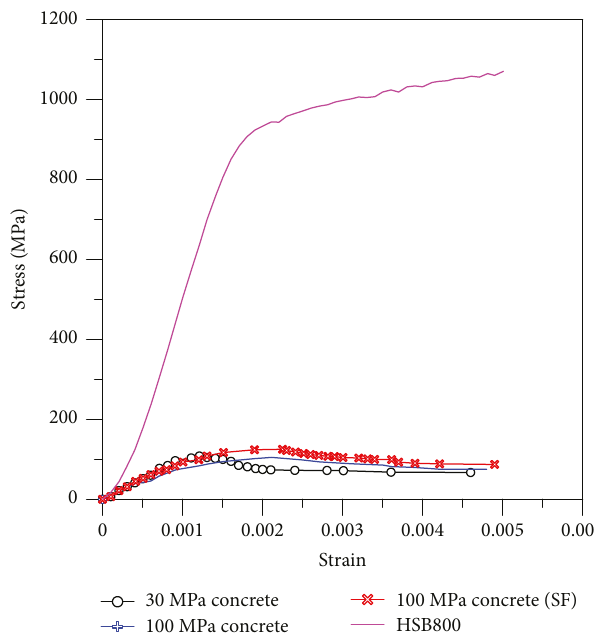
Figure 9: Stress-strain relation of concrete through the test